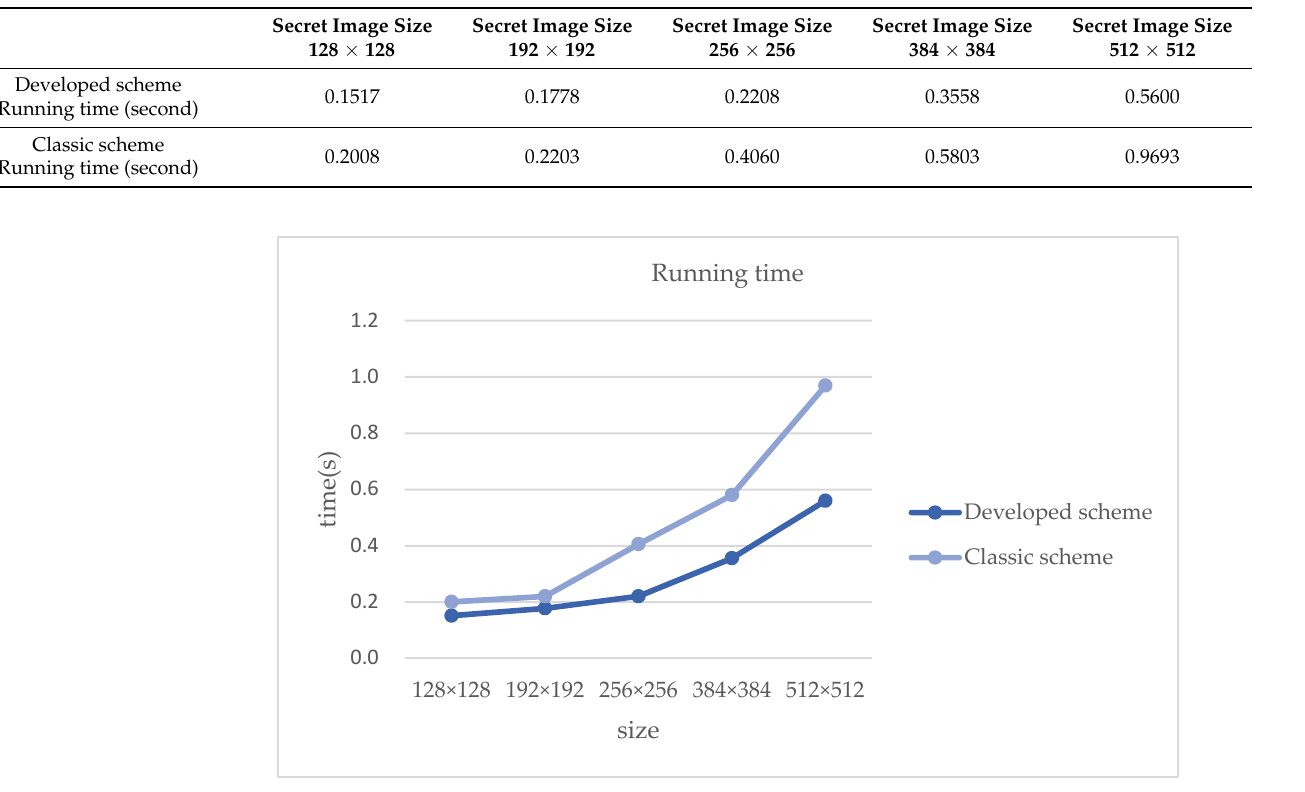
Figure 9. Running time comparison chart with different sizes in GF (251).